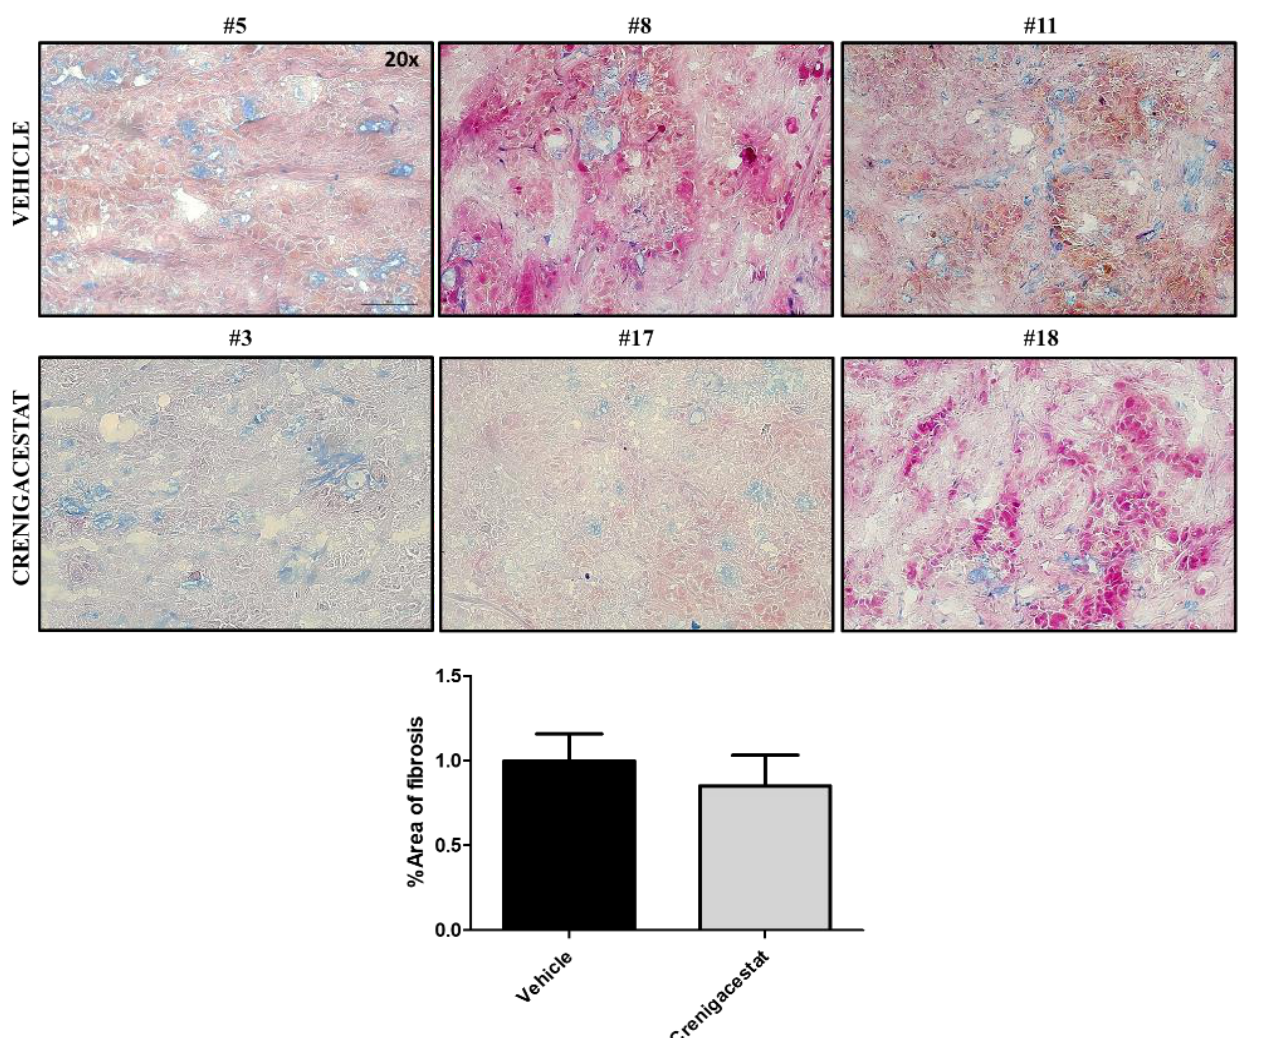
Figure 7. Crenigacestat has no effect on fibrosis in the HuCCT1-xenograft model. Tissue sections were stained using Azan-Mallory’s trichrome staining to highlight collagen fibers. Representative images of treated and untreated animals reveal collagen in aniline blue, ordinary cytoplasm in orange G, and nucleus in acid fuchsin in both conditions. Quantitative analysis of blue stained area to the total area in HuCCT1-xenograft mice treated with vehicle ( n = 8) and Crenigacestat ( n = 6) shows no significant differences between the two groups. These results indicate that Crenigacestat is not able to modulate fibrosis in this model. The images were acquired at 20 × magnification. Scale bar represents 50 μm.